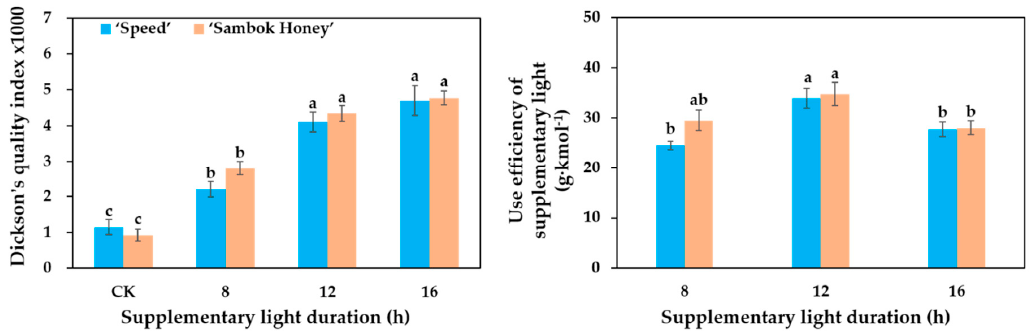
Figure 3. The effects of the supplementary light duration on the Dickson’s quality index and use efficiency of the supplementary light of two cultivars of watermelon, ‘Speed’ and ‘Sambok Honey’, grafted onto ‘RS Dongjanggun’ bottle gourd rootstocks, after 10 days of supplementary light treatments. The error bars represent the SEs of the biological replicates ( n = 3). Mean separation within columns are significantly different according to Tukey’s multiple range test at p = 0.05.